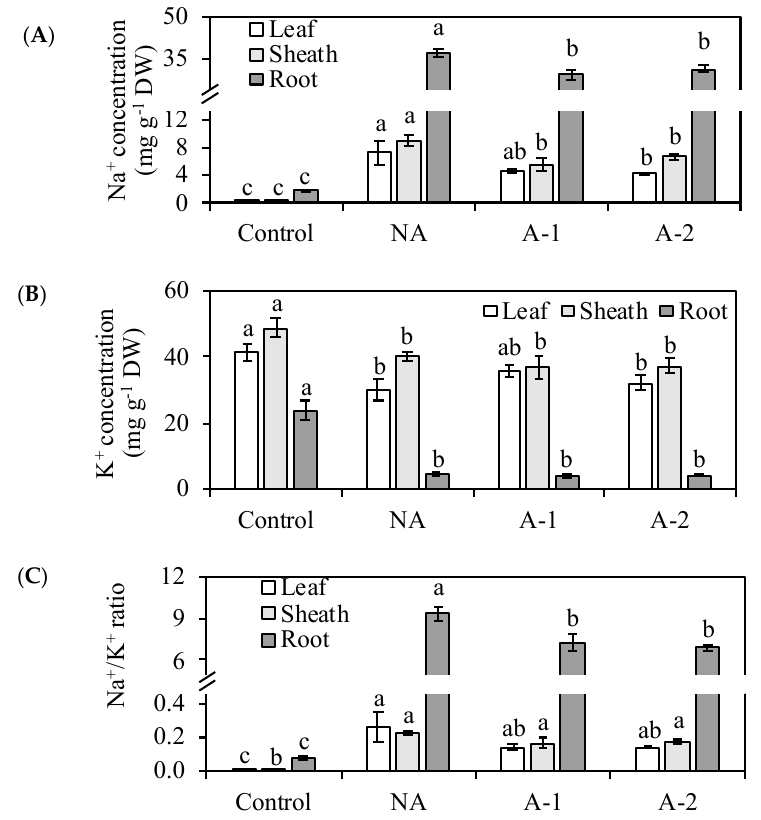
Figure 3. E ff ects of 10-days sodic-alkalinity with 100 mM NaHCO 3 on Na + concentration ( A ), K + concentration ( B ), and Na + / K + ratio ( C ) of pre-acclimated rye. Rye plants were pre-acclimated by 0 mM NaHCO 3 (NA) and 1 and 2 mM NaHCO 3 (A-1, A-2) for 10 days. Control plants were consistently irrigated by nutrient solution. Significance testing was performed using ANOVA analysis followed by Duncan’s multiple range test at p ≤ 0.05. The values are means ( ± SE) of five replicates. Means followed by the same letter are not significantly di ff